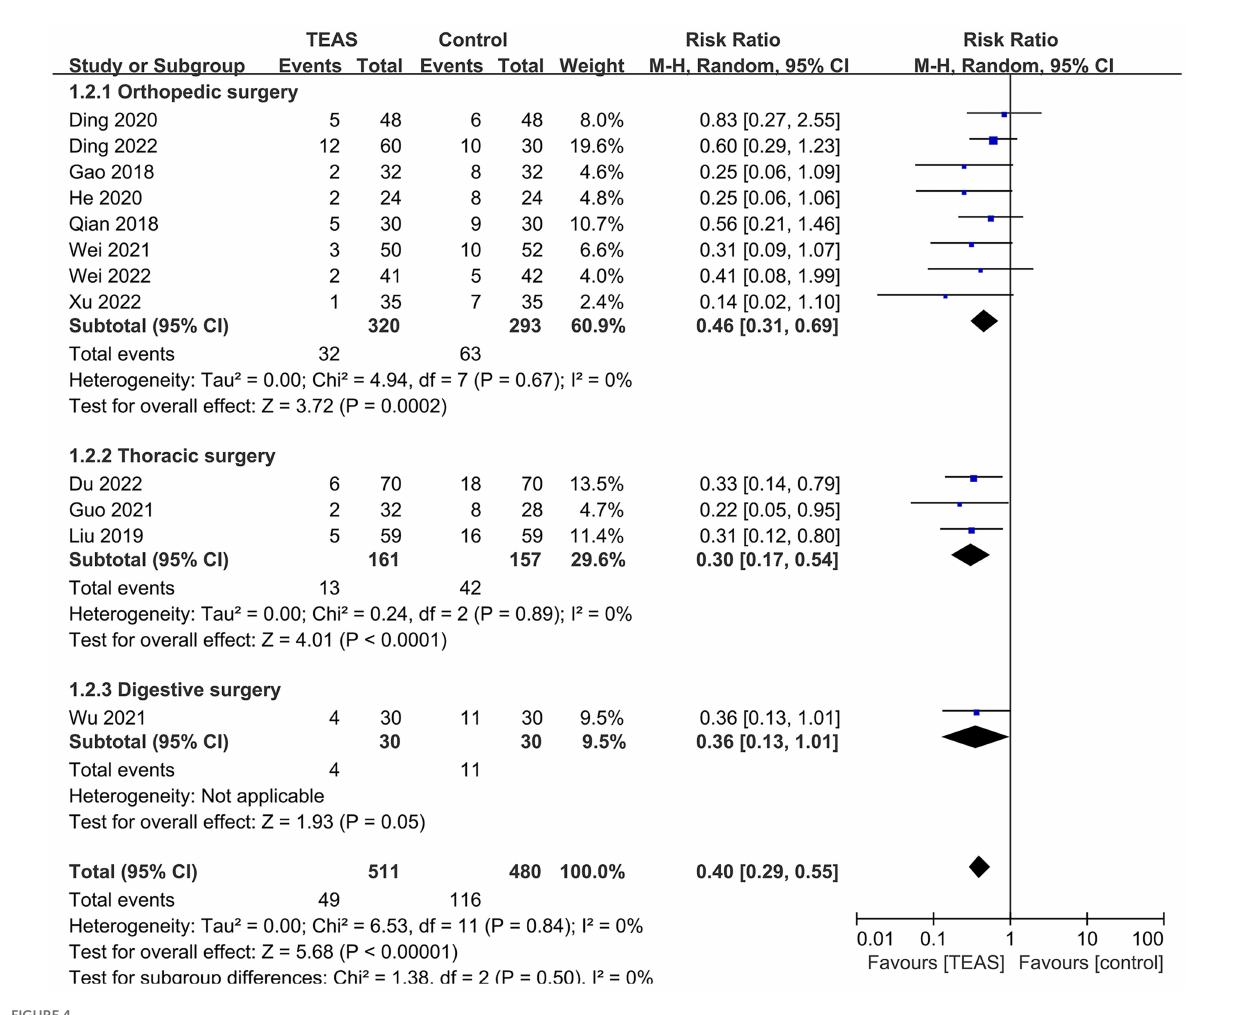
FIGURE 4 Subgroup analysis of the incidence of POD based on different types of